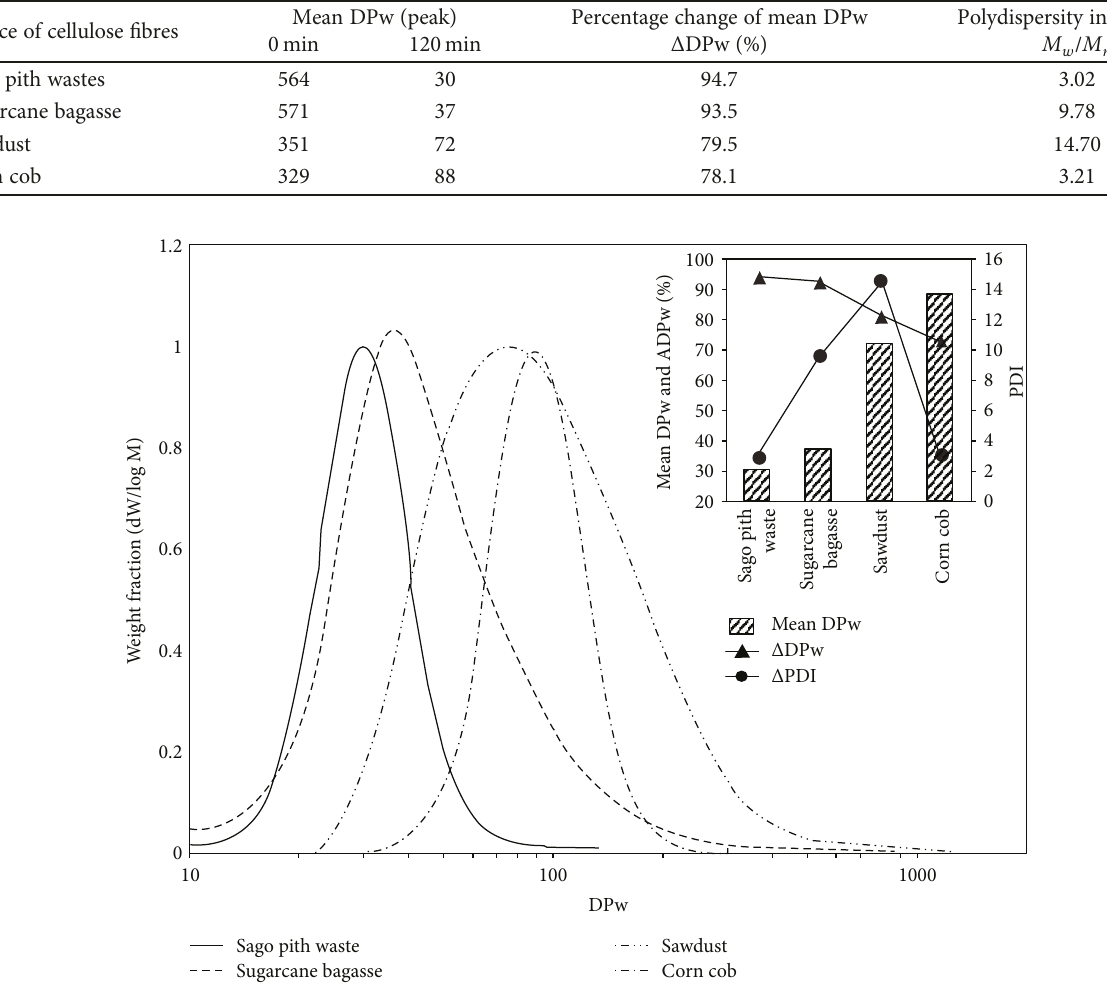
Figure 6: DPw distribution of cello-oligomers obtained from cellulose fi bres of various LBW after depolymerization for 120 min. Inset shows the mean DPw value, percentage change of mean DPw ( Δ DPw) value, and polydispersity indices (PDI) of